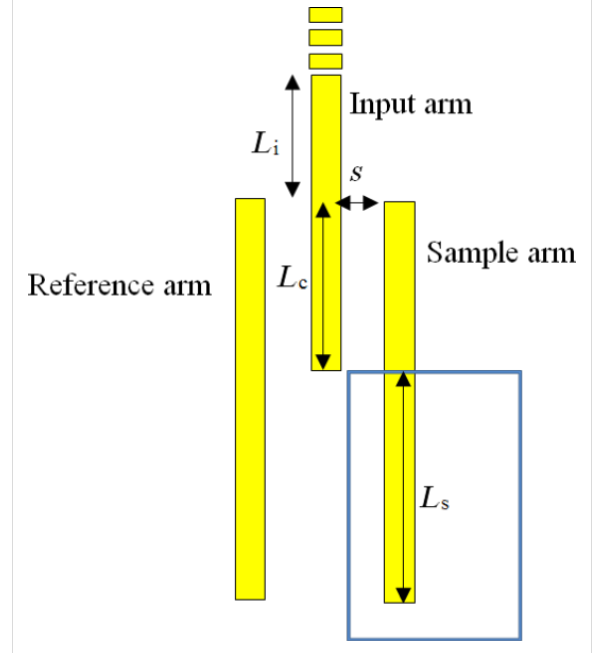
Figure 1: Schematic diagram of the proposed sensor. The sample window is shown as the blue rectangle. L i is the length of the input waveguide before coupling with the outer arms, L c is the coupling length, L s is the sample length and s is the separation between inner arm and outer